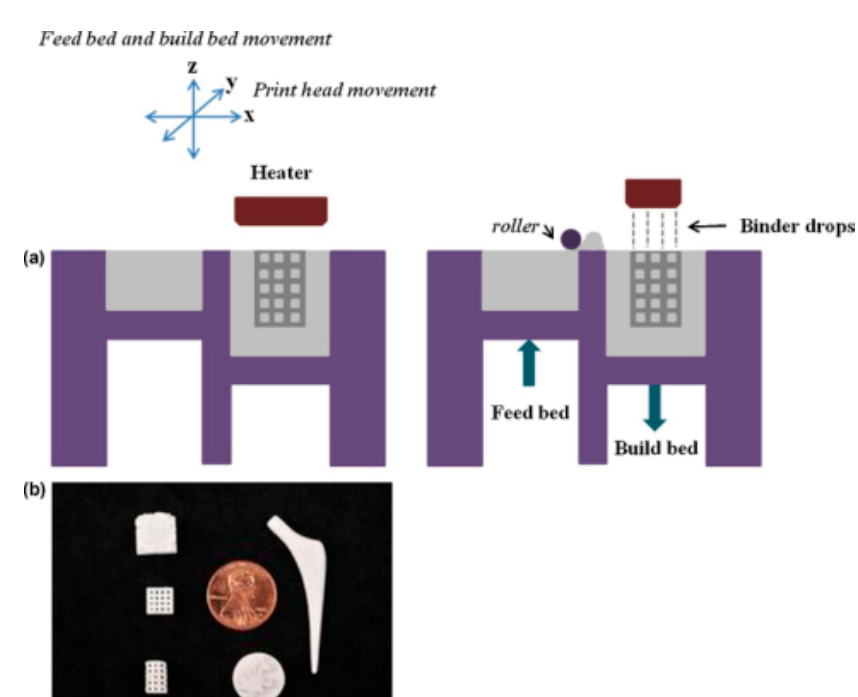
Figure 3. ( a ) 3D printing schematic using an inkjet printing system; and ( b ) 3D printed calcium phosphate (CaP) sintered structures fabricated at Washington State University using a 3D printer (ProMetal ® , ExOne LLC, Irwin, PA, USA) [41].